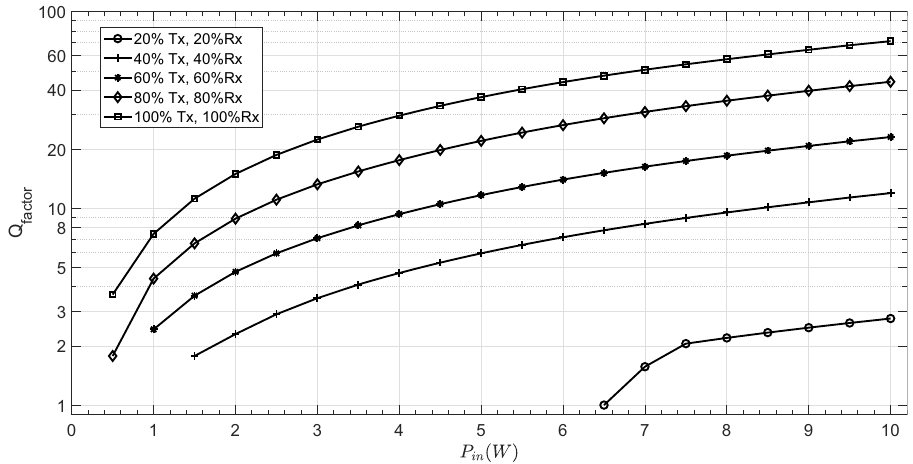
Figure 7: Quality factor ( Q factor ) as a function of the transmitted laser power ( P in ) for a di ff erent telescope e ffi ciency W/zero pointing